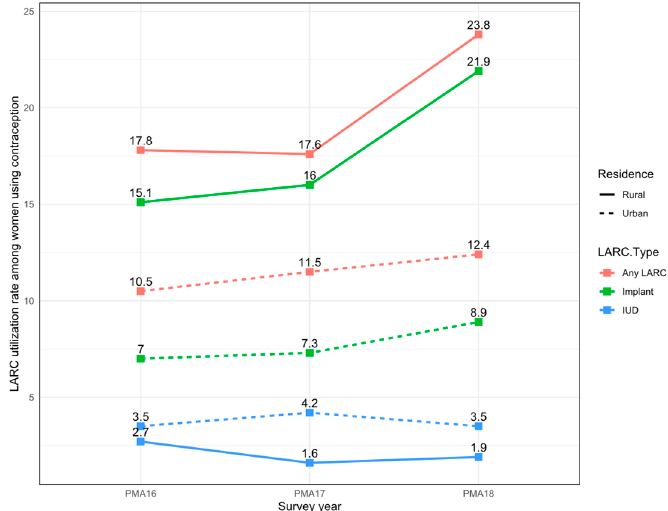
Figure 2. Trends in long-acting reversible contraception (LARC) use, intrauterine device (IUD) use, and implant use PMA2020, 2016–2018. Error bars represent 95% confidence intervals.